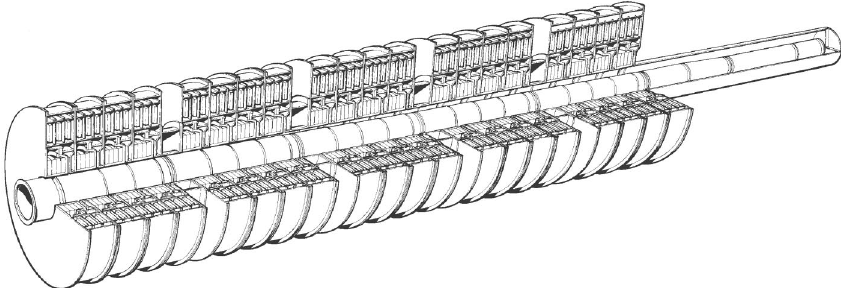
FIG. 33. Cutaway of Hermes-III IVA, showing vacuum power flow region, stalk, and some cell details.